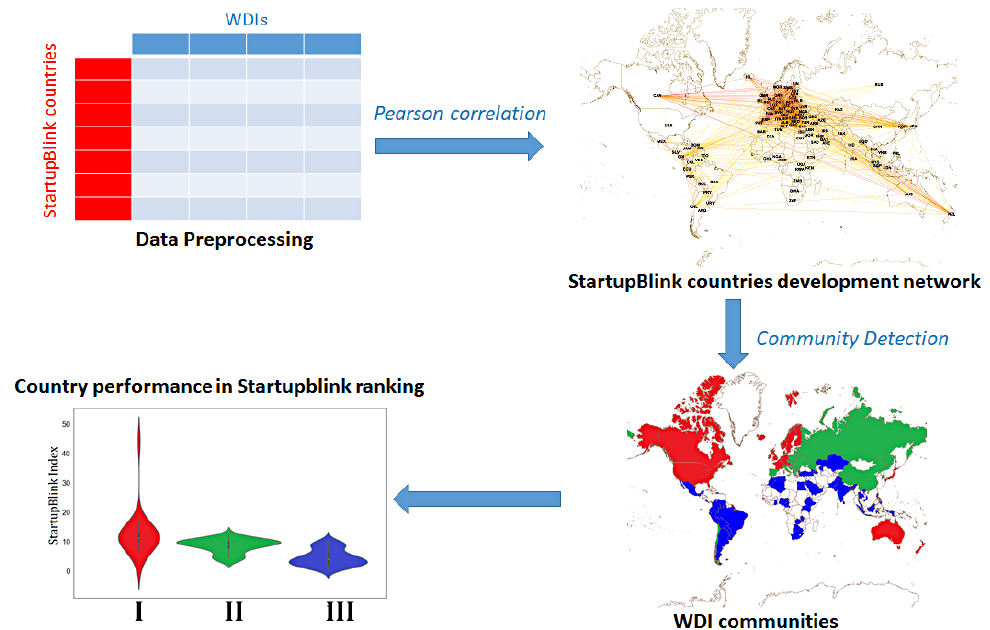
Figure 1. Pipeline representation. First, data related to the StartupBlink countries were collected from the WDI database and preprocessed ( top left ); then, a similarity network was built, in which links between two countries were weighted by the Pearson correlation between their sets of WDIs, provided it was statistically significant ( topright ); finally, community detection was performed on the similarity network to detect homogeneous groups of countries ( bottom right ), which were used to reinterpret their achievements in the StartupBlink rankings ( bottom left